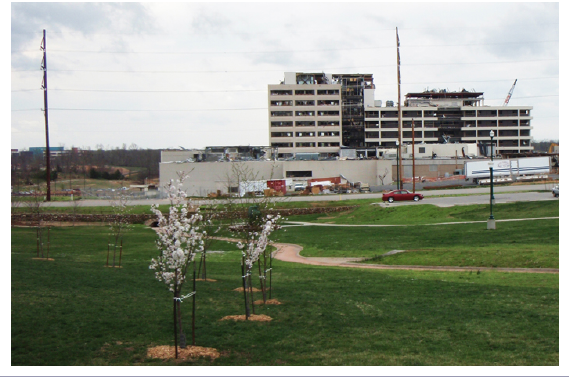
Fig. 6 . Memorial trees planted in Cunningham Park, Joplin, Missouri after 2011 tornado. Photo: K. G. Tidball.